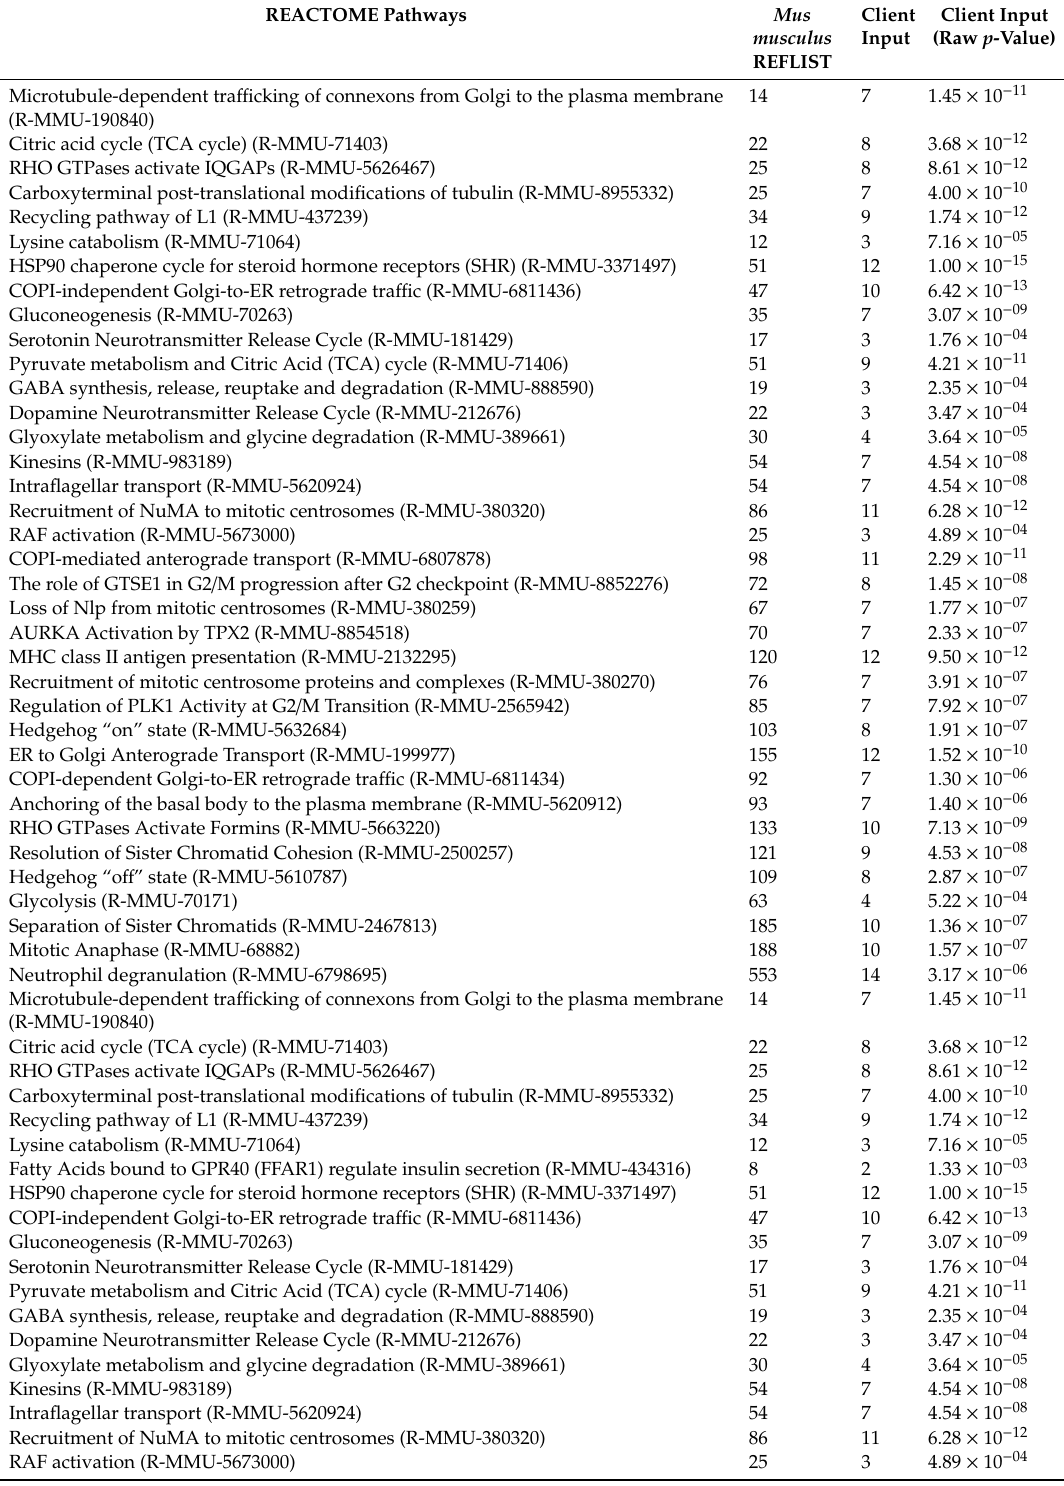
Table 2. REACTOME pathway classification of murine NAGLU − / − brain tissue proteome. REACTOME